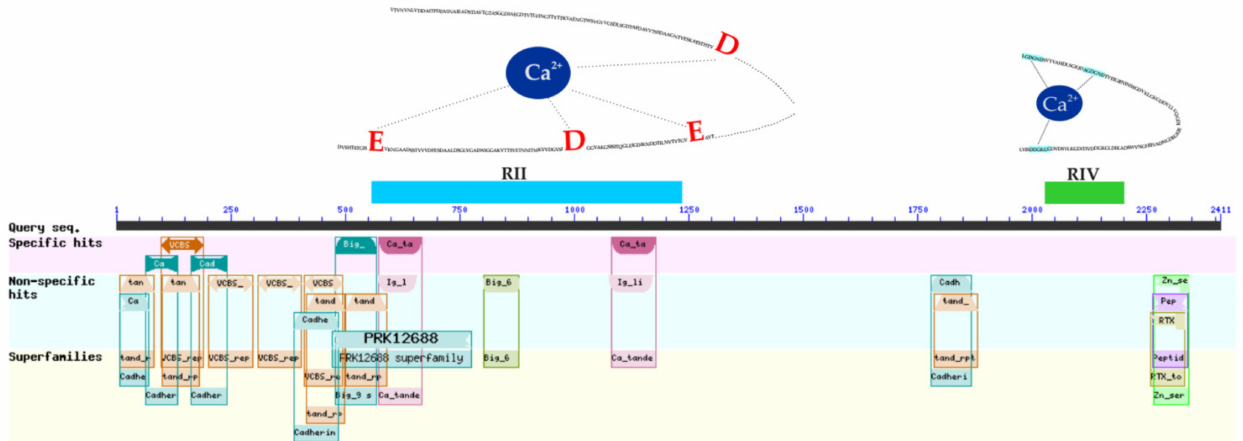
Figure 5. Domain organization of antifreeze protein M. primoryensis KMM3633 T (MP3633_2272). VCBS (Vibrio, Colwellia, Bradyrhizobium, and Shewanella)—VCBS repeat; Big_9—bacterial immunoglobulin-like domain; Ca_ta—Ca 2+ -stabilized repeat; Cadher—cadherin-like domain; tan— 95 aa tandem repeat; RTX—RTX family hemolysin; Big_6—bacterial immunoglobulin-like domain; PRK12688—flagellin. Blue rectangle—kernel structure forming Ca 2+ -binding RII region; green rectangle—ice-binding RIV region. The Ca 2+ binding residues in the RII region are marked in red, and those in the RIV region are marked in